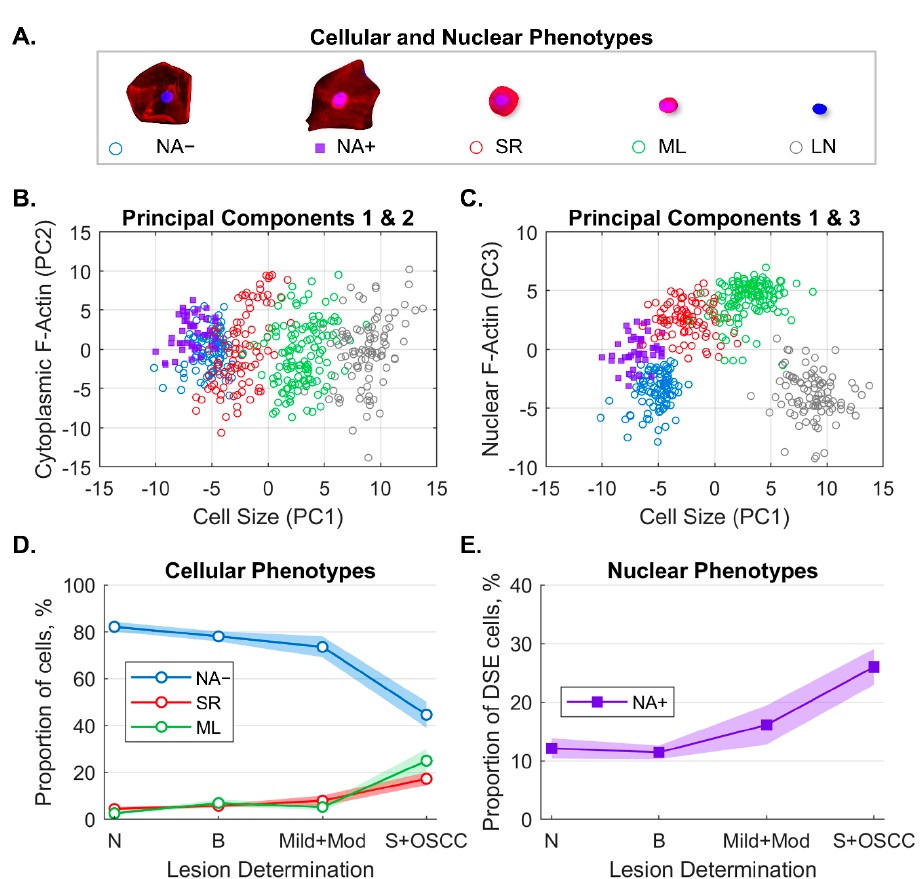
Figure 5. Machine learning algorithm to classify and count cellular and nuclear phenotypes. Five cellular/nuclear phenotypes were identified ( A ). Principal component analysis of phenotypes shows clusters of phenotypes for PC1 vs. PC2 ( B ) and PC1 vs. PC3 ( C ). The majority of variance was ex- plained by cell size (PC1), cytoplasm F-actin (PC2), and nuclear F-actin (PC3). Distributions of cel- lular phenotypes ( D ) and nuclear phenotypes ( E ) identified by machine learning within each lesion class (solid line = cell percentages, fill = 95% CI). Panel E shows the fraction of NA+ cells out of all